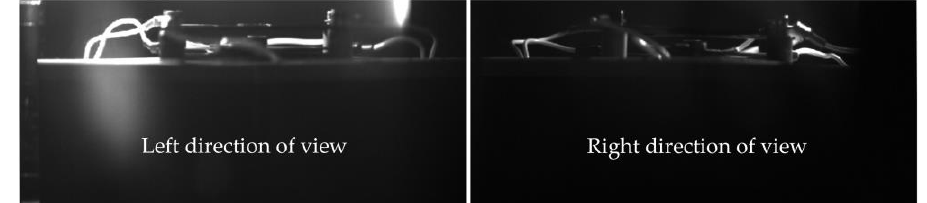
Figure 6. Recorded image after adjustment of the system. The white line in the middle of the image symbolizes the separation of the camera chip according to Figure 5b.